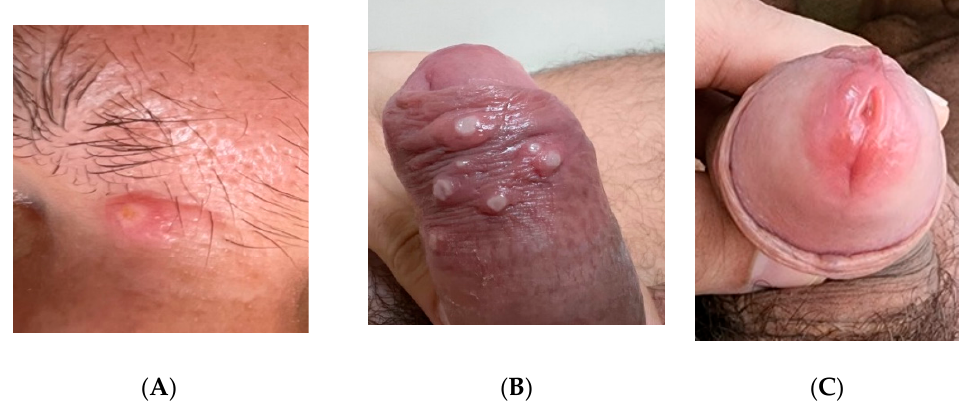
Figure 1. Acute lesions presented by the first case ( A – C ).